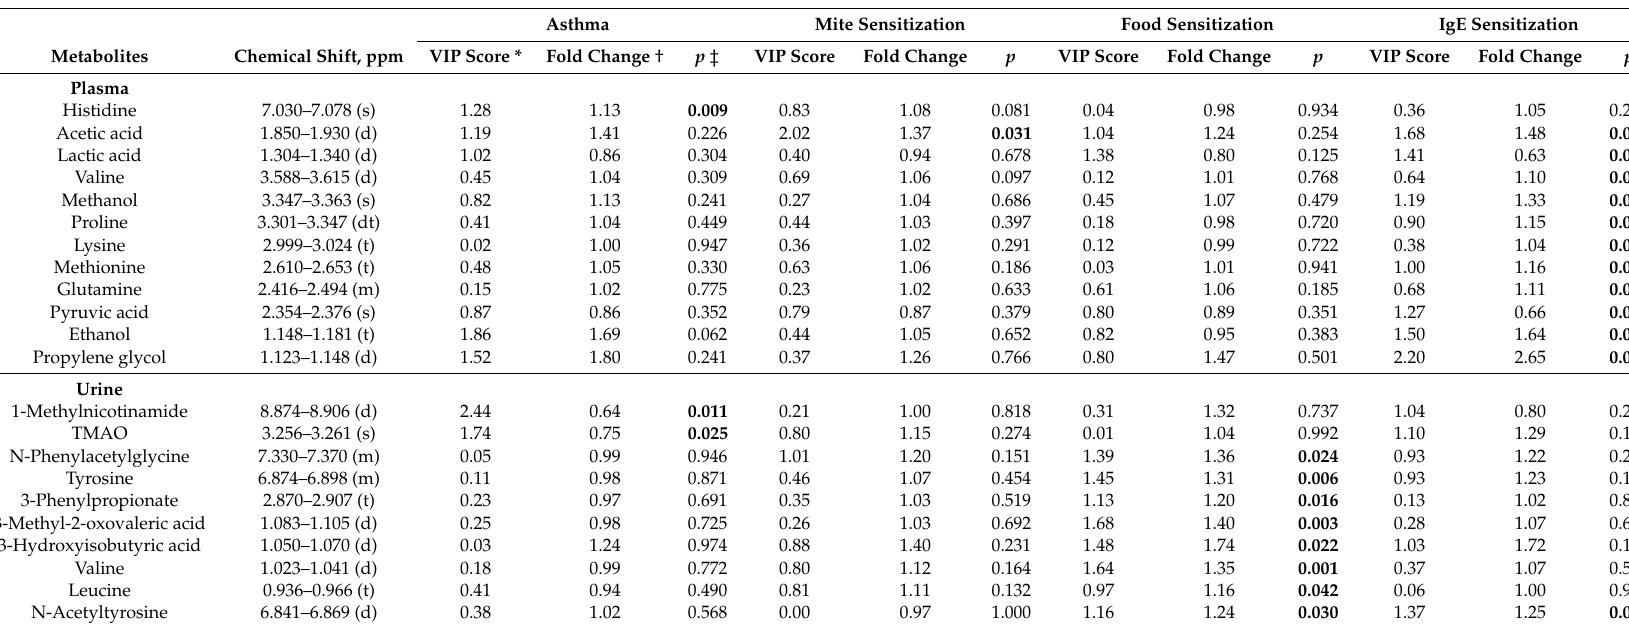
Table 2. The VIP score and fold change of metabolites significantly di ff erentially expressed between children with asthma and controls, and between children with and without mite, food and IgE